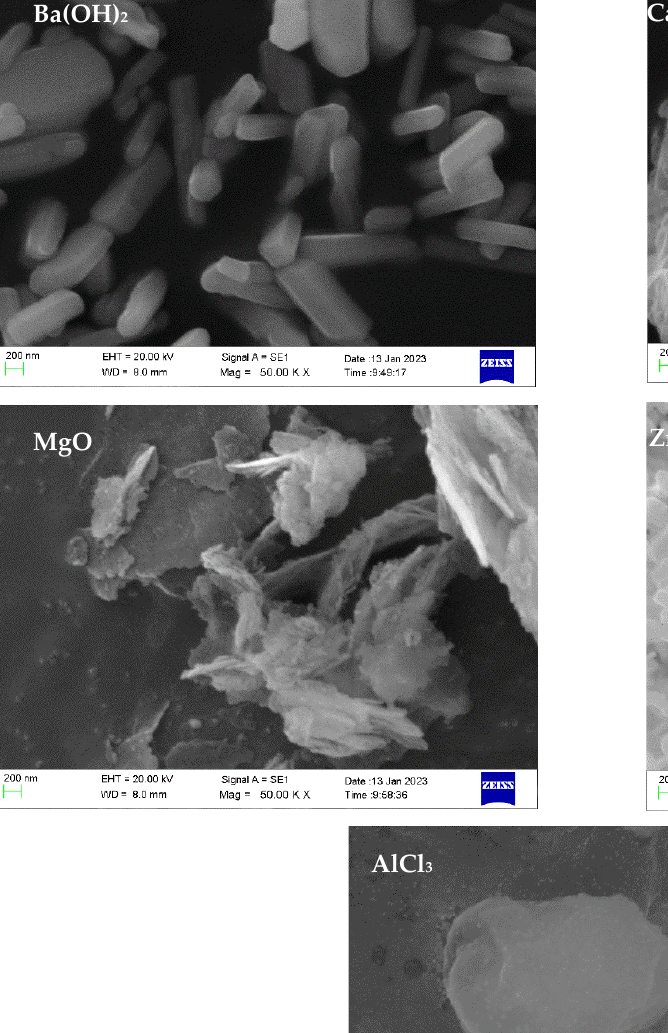
data [JCPDS file: 45-0946]. The XRD spectra indicate that the ZnO crystal is as shown in Figure 14. The major diffraction peaks were seen at angles of 31.796 ◦ , 34.452 ◦ , 36.282 ◦ , 47.568 ◦ , 56.624 ◦ , 62.886 ◦ , 66.402 ◦ , 67.975 ◦ , 69.113 ◦ , 72.592 ◦ , and 76.983 ◦ . The diffraction peaks of ZnO can be matched with CPDS data [JCPDS file: 00-036-1451. Figure 15 illustrates the XRD pattern of the compound AlCl 3 . At several different 2 θ values, the principal peaks can be recognized. The diffraction peaks of AlCl 3 can be matched with CPDS data [JCPDS file: 00-08-04531].